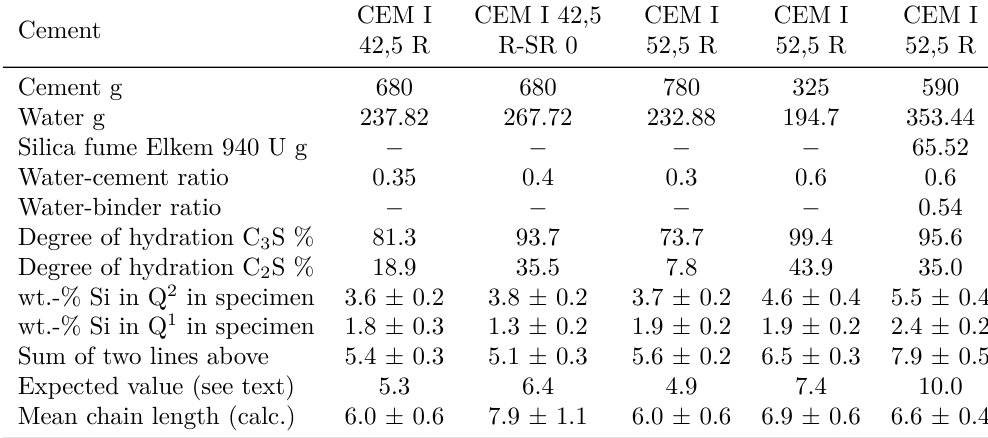
Table 3. Plausibility tests with hydrated